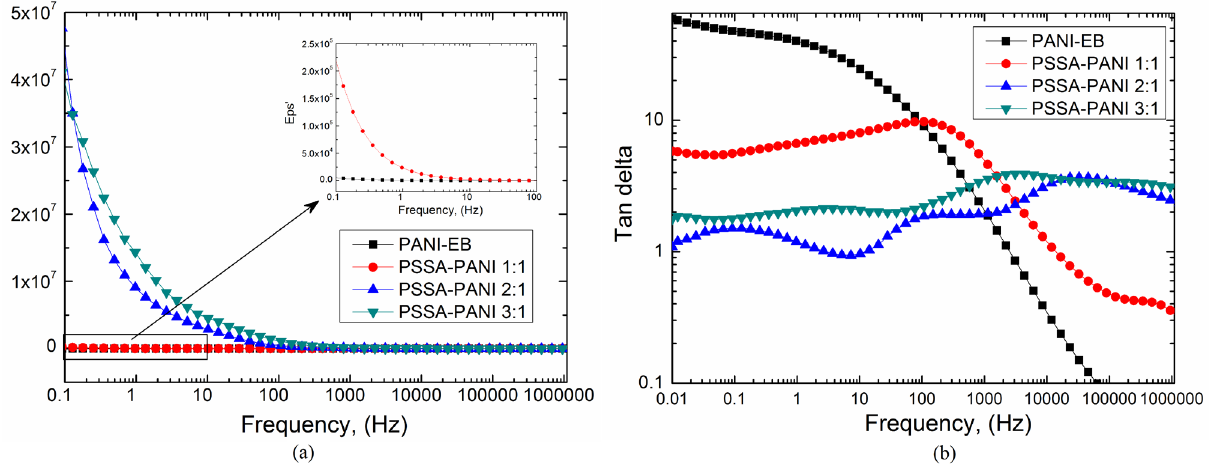
Figure 8: Dielectric constant (a) and dielectric losses (b) dependency on